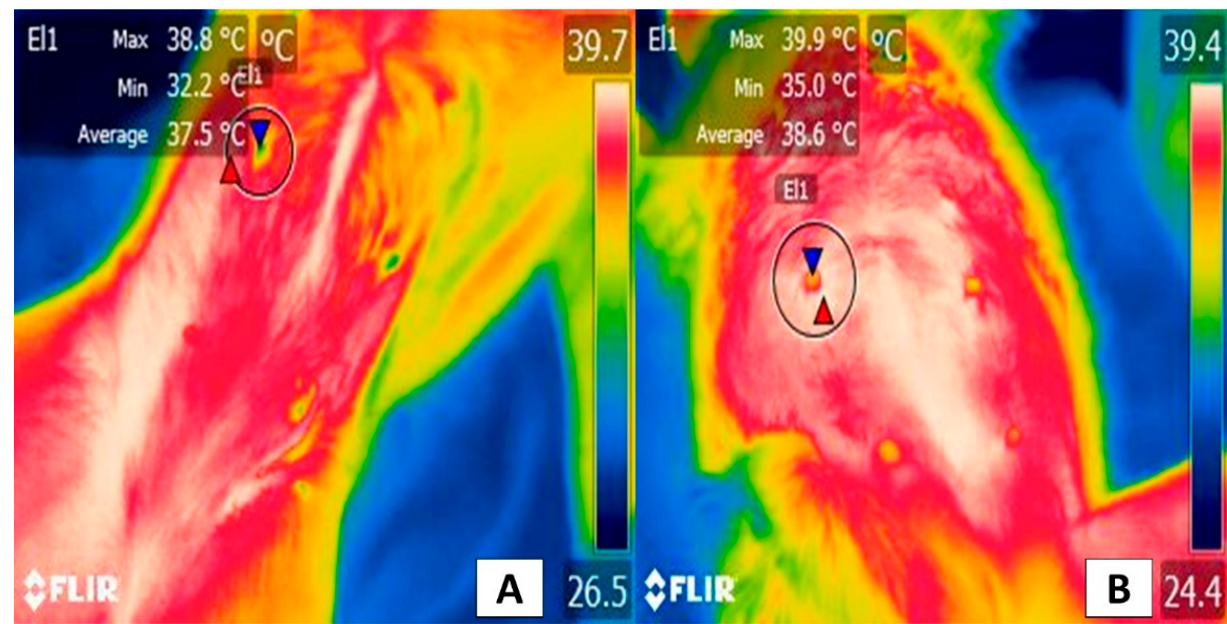
Figure 7. The thermal window of the mammary gland: ( A ) Healthy gland. The window of the mammary gland (El1) is shown in a 4-year-old Doberman Pinscher female dog. A maximum temperature of 38.8 °C (red triangle) and a minimum of 32.2 °C (blue triangle) can be seen. ( B ) Gland with the presence of tumors. An 8-year-old female dog of the Maltese breed with 0.5 to 1 cm diameter tumors in the left abdominal gland (El1). In this region, the temperature is 1.1 °C higher in the maximum values (red triangle), while the minimum is 2.8 °C higher (blue triangle), compared to the temperature shown in a healthy gland. The increase in temperature at the local level is due to cancer cells releasing pro-inflammatory substances such as serotonin, histamine, prostaglandin F2 α , and tumor necrosis factor α promoting vasodilation of superficial blood capillaries, causing an increase in the radiation emitted. Thermal images obtained using a FLIR thermal camera.